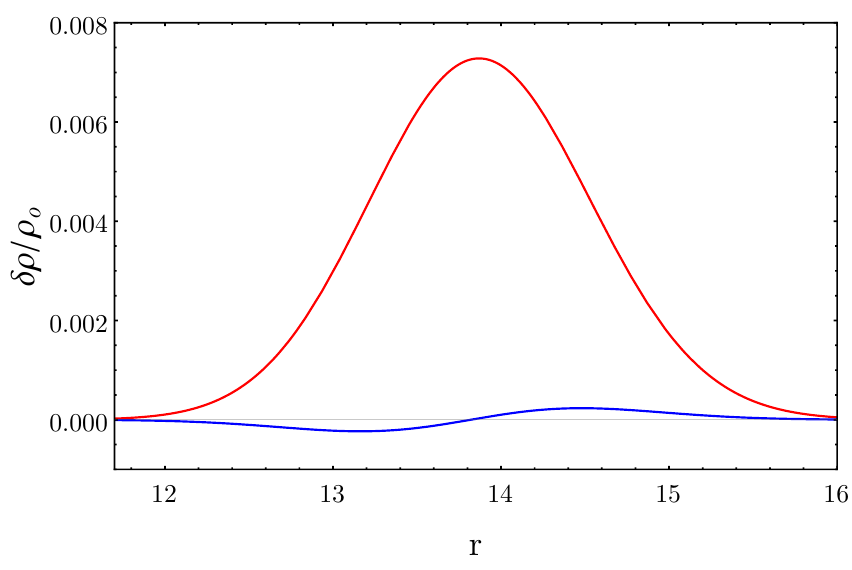
Figure 3 . Radial density profile of k = 1 neutral edge excitation (blue) and Q = 1 / 3 charged fluctuation (red) for ν = 1 / 3 . The ground-state density profile terminates at r ∼ 15 (not plot- ted) ( N = 64